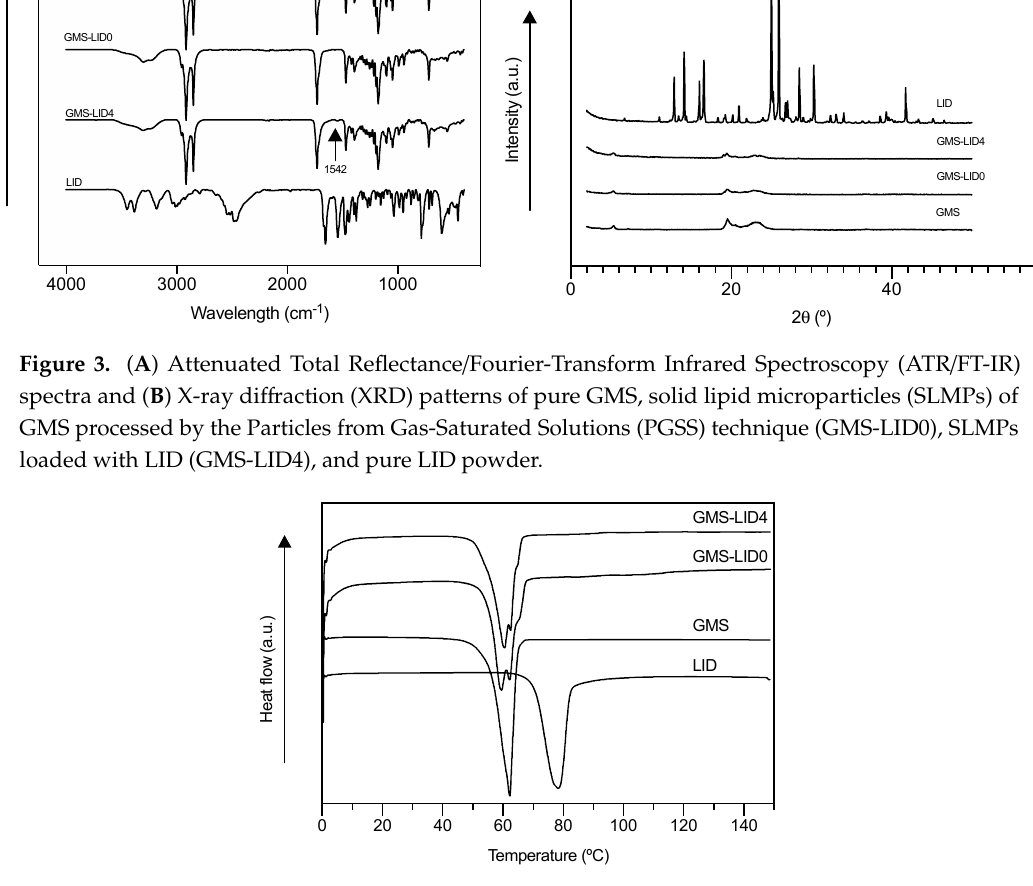
Figure 4. Differential scanning calorimetry (DSC) thermograms of the raw materials, GMS-LID0 and GMS-LID4 particles. No peaks corresponding to crystalline LID were appreciated in the GMS-LID4 particles. Table 1. Thermal properties of raw materials and GMS particles processed without (GMS-LID0) and with LID